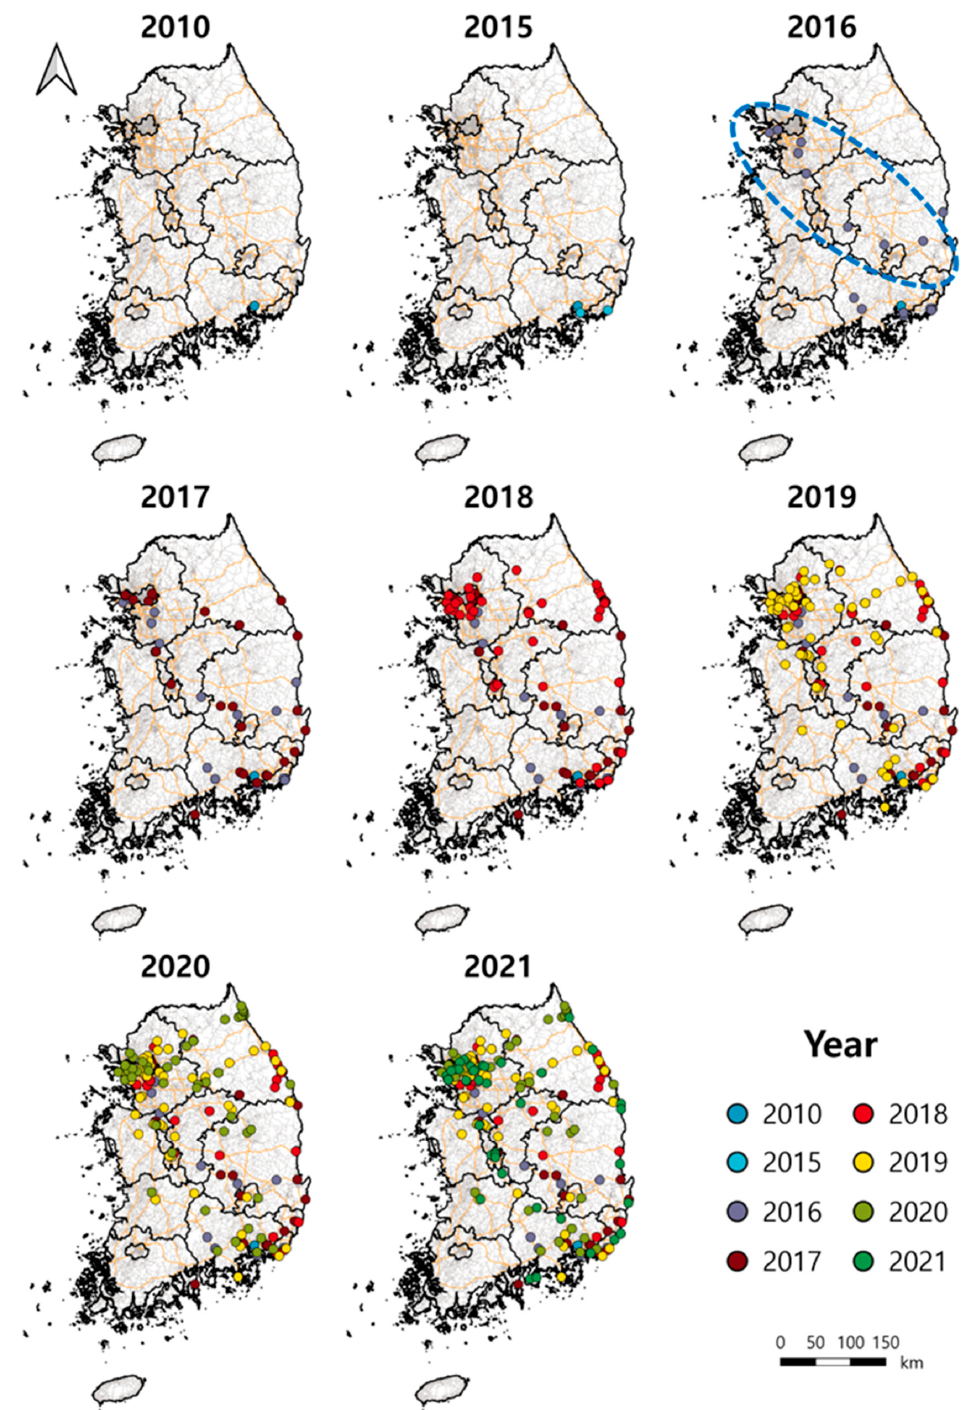
Figure 1. Dispersal of the WCSB populations in Korea between 2010–2021 [3,6,11,22] (data for 2019~2021 obtained from the field) (Orientation in all subfigures is the same shown in year 2010).